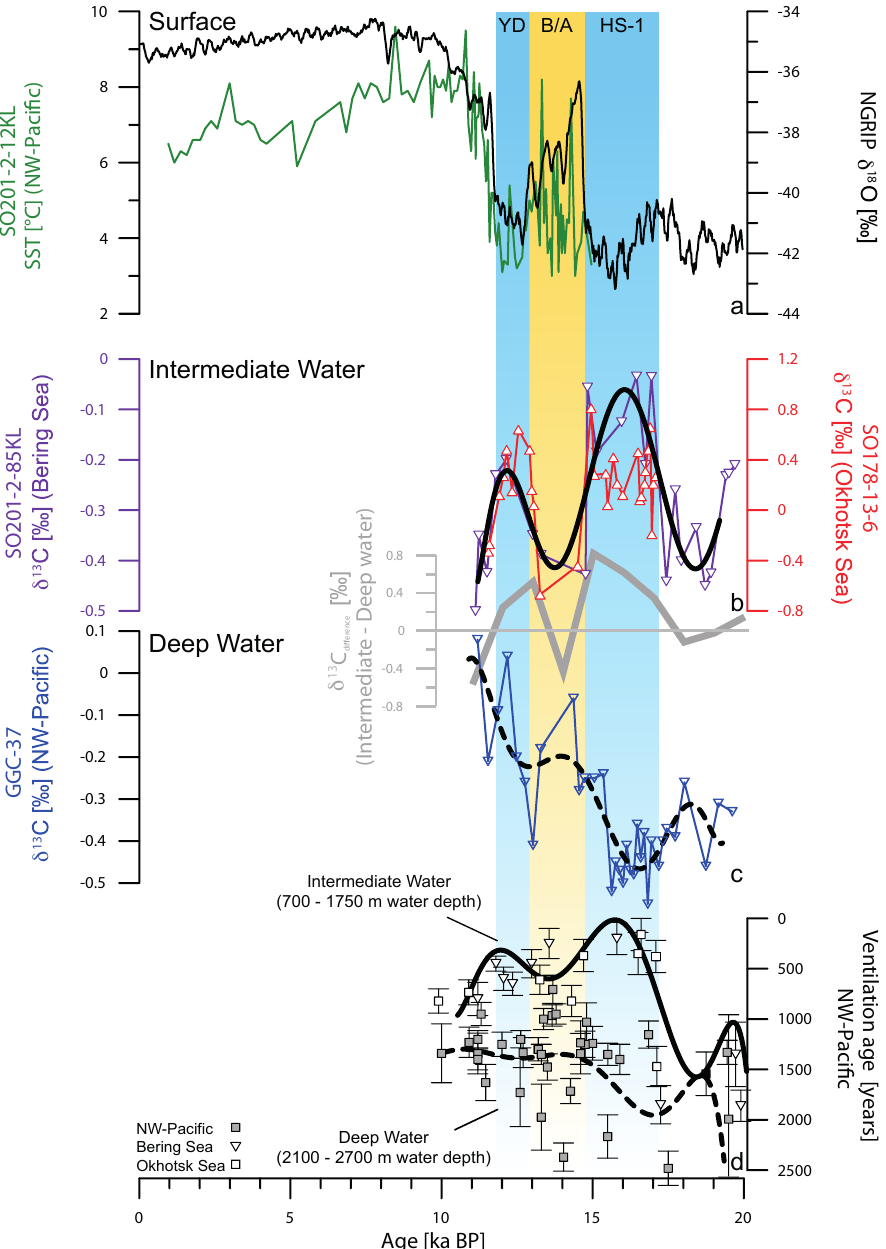
Fig. 5. Sediment proxy records of changes in surface-, intermediate- and deep-water properties in the northwest Pacific realm during the past 20kyr. Blue and yellow shaded bars mark HS-1 and YD as well as the Bølling/Allerød interstadial. From top to bottom (a) alkenone- based sea surface temperature record of sediment record SO201-2-12KL (in green) from the northwest Pacific (Max et al., 2012) for the last 15kyr together with NGRIP oxygen isotope record in black (Rasmussen et al., 2006). (b) Benthic foraminiferal δ 13 C-records ( C. lobatulus ) from the Okhotsk Sea ( ∼ 700m water depth; red curve) and Bering Sea ( ∼ 1000m water depth; purple curve) together with smoothed spline interpolation of the records (thick black line). (c) Benthic δ 13 C-record from sediment record GGC-37 (Keigwin, 1998) from the deep northwest Pacific ( ∼ 3300m water depth, blue curve) and smoothed spline interpolation of the record (stippled black line). Thick gray line gives difference between intermediate- to deep-water δ 13 C records. (d) Okhotsk Sea and Bering Sea intermediate-water ventilation ages obtained in this study (700–1750m water depth; open squares and triangles) compared to deep-water ventilation ages (2100–2700m water depth; gray squares) of the northwest Pacific (Murayama et al., 1992; Sarnthein et al., 2006; Minoshima et al., 2007; Okazaki et al., 2012; this study). Calculated error bars are given for each estimated ventilation age. Smoothed spline interpolations for intermediate- and deep-water ventilation ages are given by the thick black line (intermediate water) and thick stippled black line (deep water),